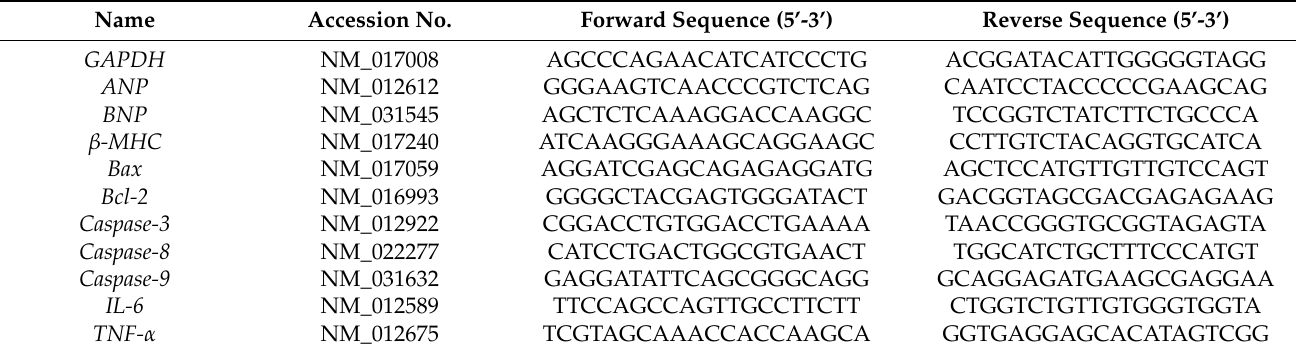
Table 1. Primer sequences for quantitative real-time